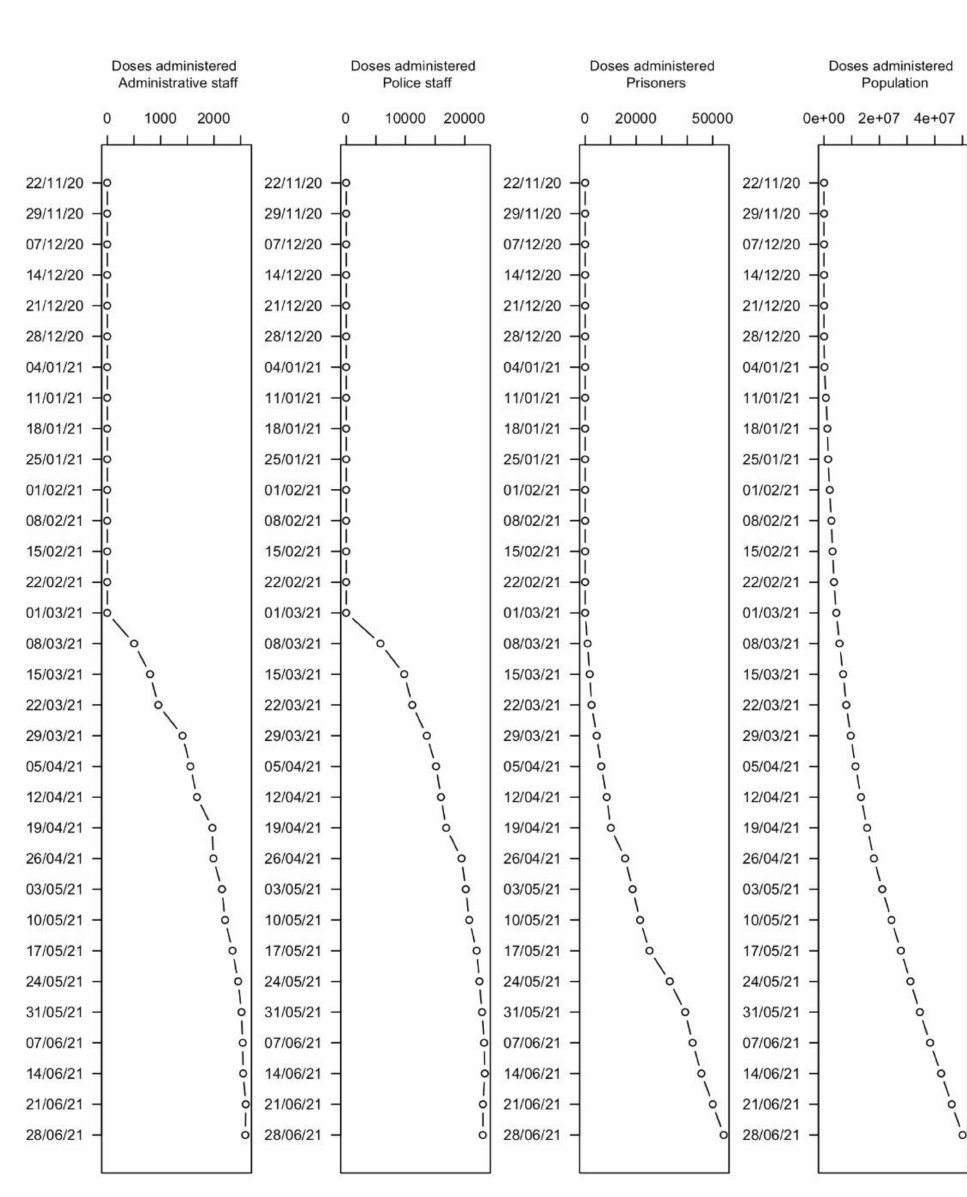
Figure 4. Number of administered doses of vaccine (from top to bottom): Italian population; prisoners; police staff; and administrative